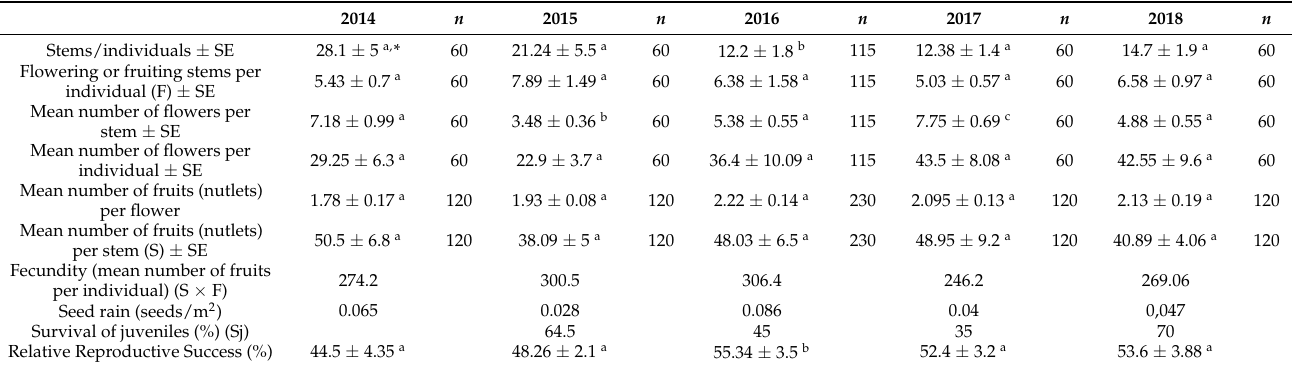
Different letters represent significant differences (p < 0.05) among the study years, for each reproductive parameters.